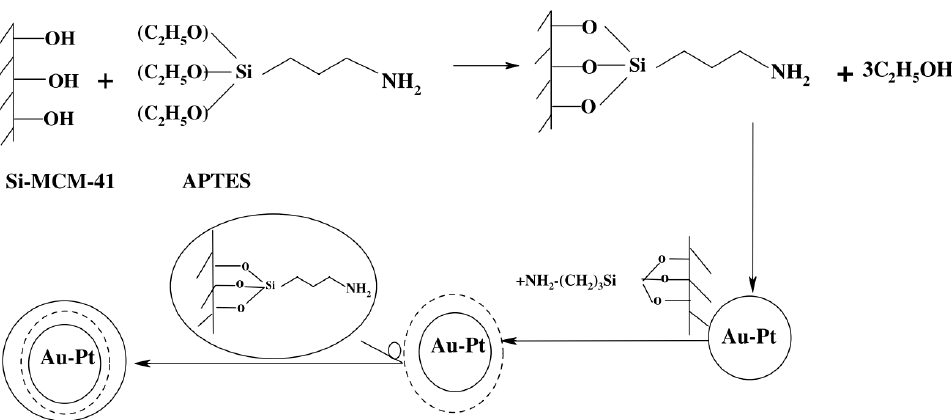
Figure 50. The possible mechanism of amine functionalization and subsequent introduction of the metals into Si-MCM-41. Reproduced with permission from [107]. Copyright 2006 Elsevier B.V.